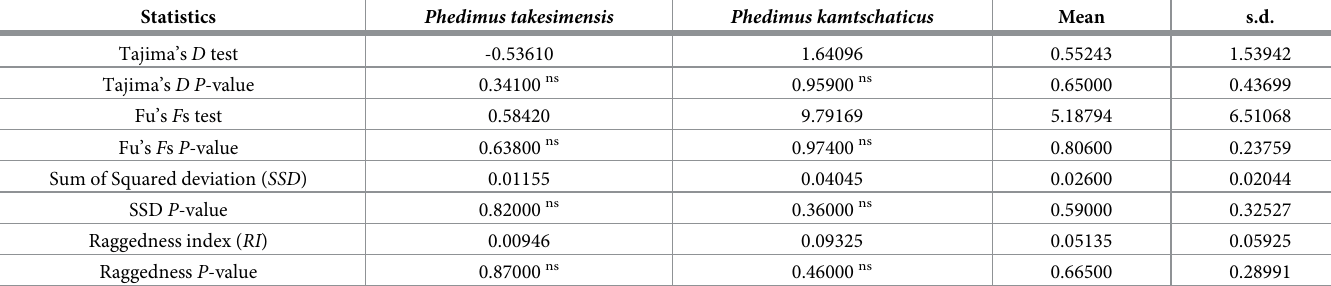
Table 5. Neutrality and population expansion tests for Phedimus takesimensis and P . kamtschaticus .